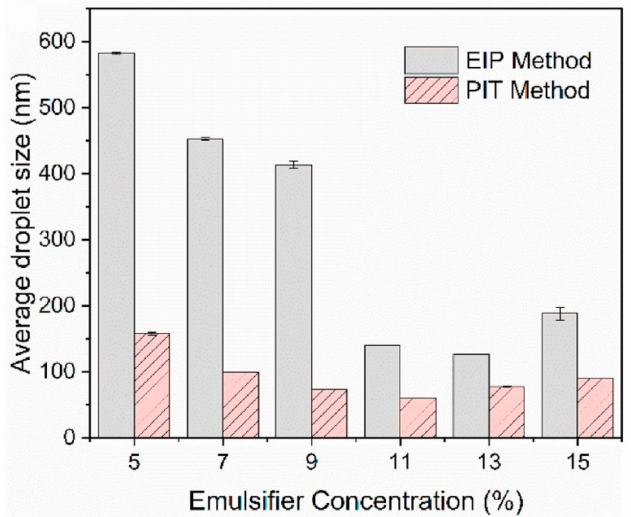
Figure 9. Comparison of droplet sizes of hexadecane emulsion between PIT and PIC methods (Reproduced with permission from Ref. [97]. Copyright 2021